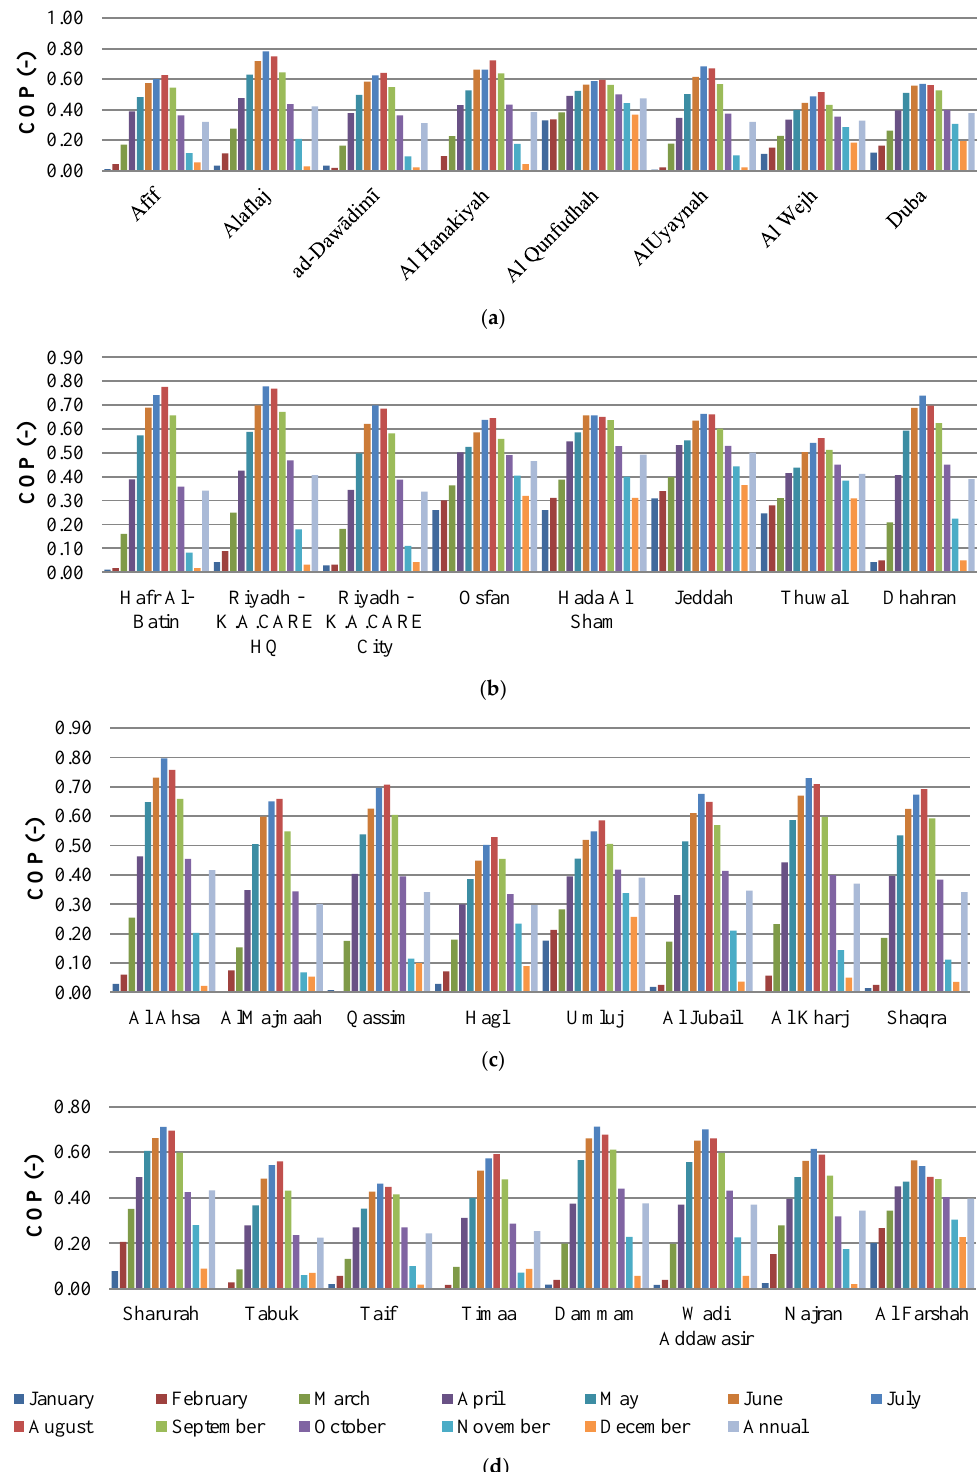
Figure 9. Monthly variations of coefficient of performance for ( a ) Afīf, Alaflaj, ad-Dawādimī, Al